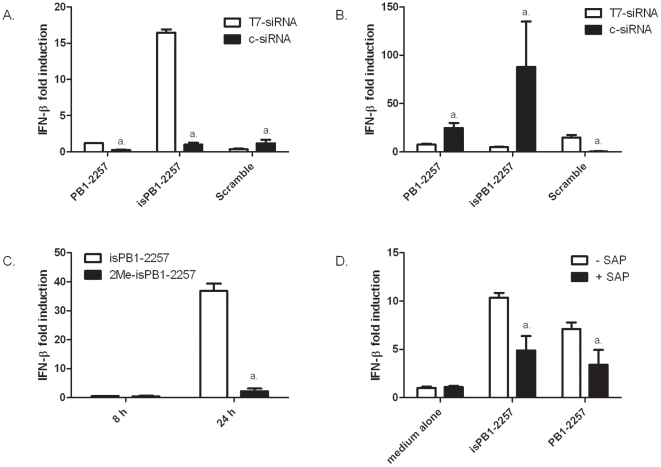
Immunostimulatory properties of T7-siRNAs and c-siRNAs in chicken cells.IFN-β mRNA levels were measured in DF-1 cells transfected with T7-siRNAs (white bars, 20 pmol) or c-siRNAs (black bars, 20 pmol) at (A) 8 h or (B) 24 h. a = p<0.05 between paired white bars (T7-siRNA) and black bars (c-siRNA). (C) IFN-β mRNA levels in DF-1 cells induced by isPB1-2557 (chemically synthesized, 20 pmol) or 2Me-isPB1-2257 (chemically-synthesized, 20 pmol). a. = p<0.001 between isPB1-2257 and 2Me-isPB1-2257 at 24 h. (D) IFN-β mRNA levels in DF-1 cells transfected with T7-siRNAs (20 pmol) untreated (white bars) or treated with shrimp alkaline phosphatase (SAP) (black bars). Data shows IFN-β mRNA levels 8 h post-transfection. a. = p<0.05 between levels of IFN-β in cells transfected with untreated siRNAs or SAP-treated siRNAs. Results are representative of 3 separate experiments.